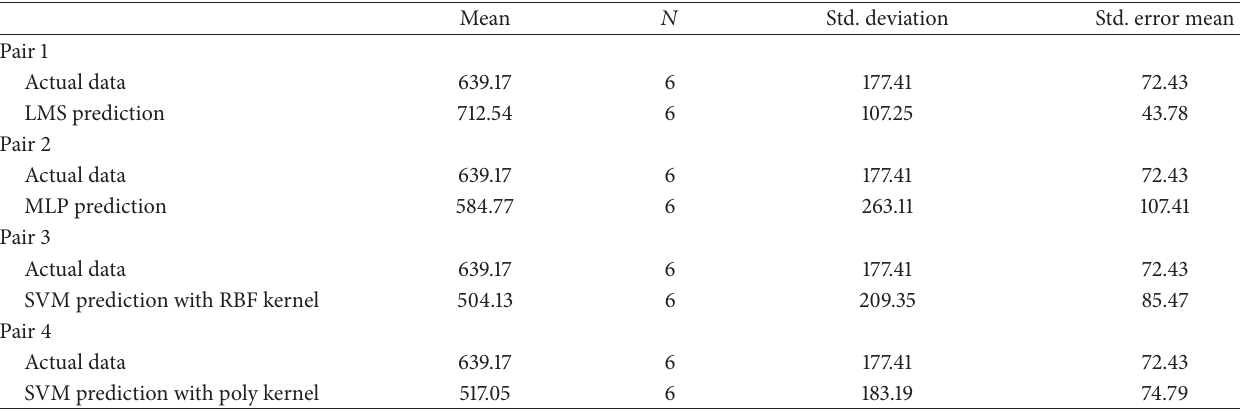
Table 7: Paired samples statistics.